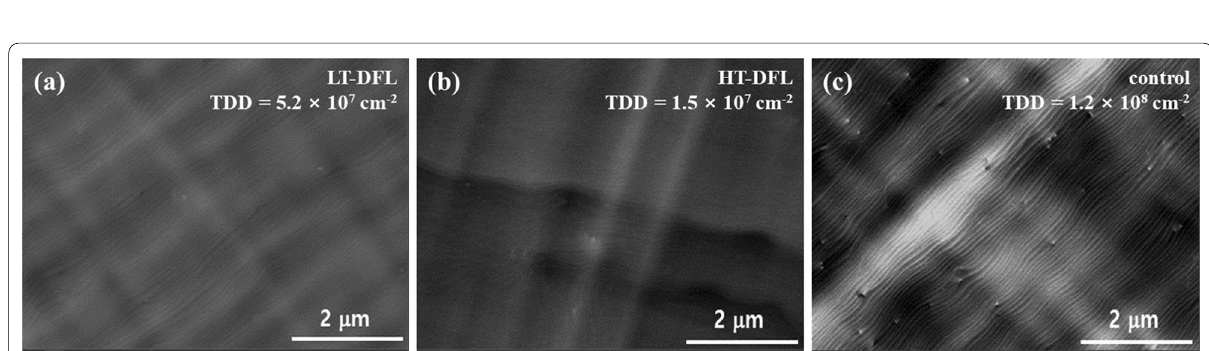
Fig. 2 ECCI images of GaAs‑on‑Si templates with DFLs and without DFLs. a , b ECCI images of LT‑DFL and HT‑DFL, respectively. c ECCI image of GaAs‑on‑Si without DFLs as a control